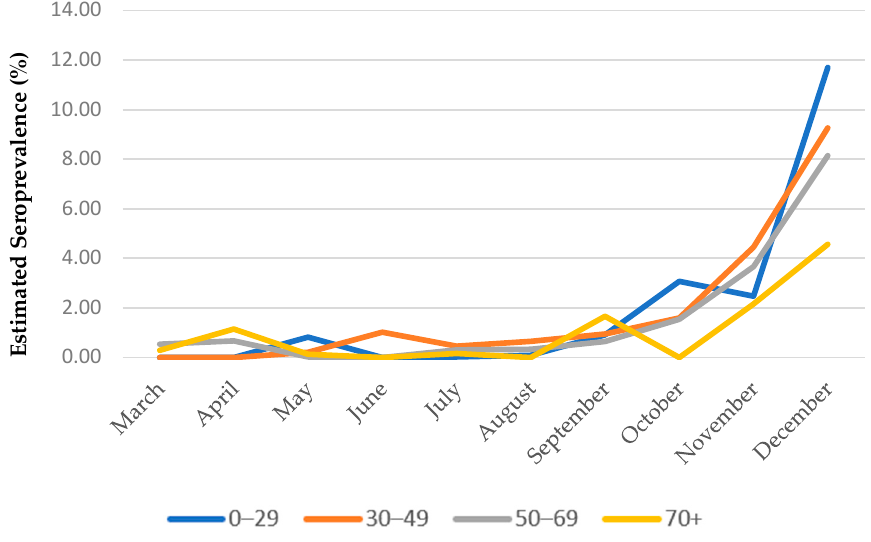
Figure 2. Evolution of estimated monthly seroprevalence (S3) by age group from March to December 2020.